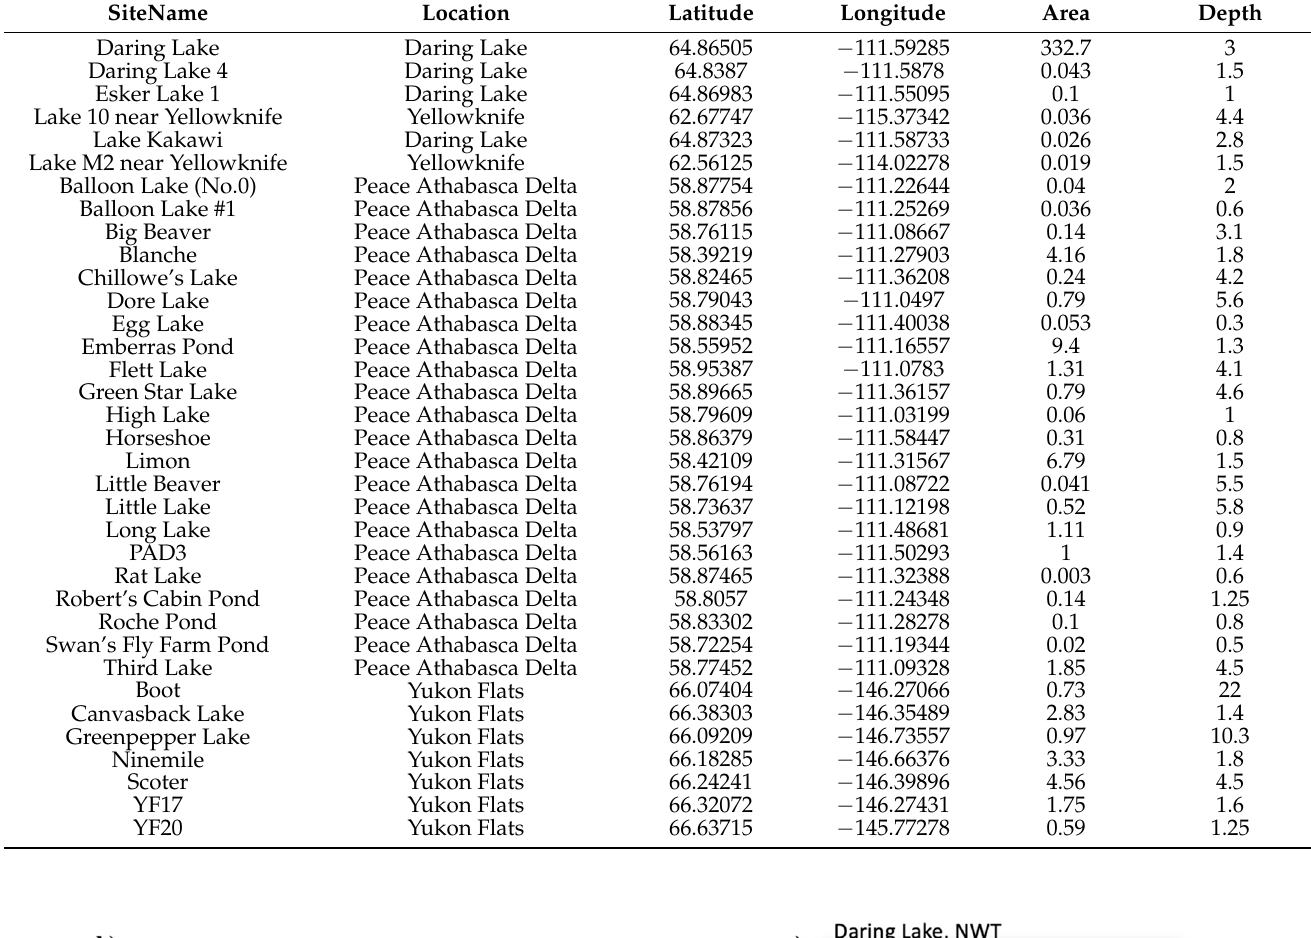
Table 1. Field sites and coordinates. Coordinates represent NASA ABoVE field campaign in situ sampling sites.